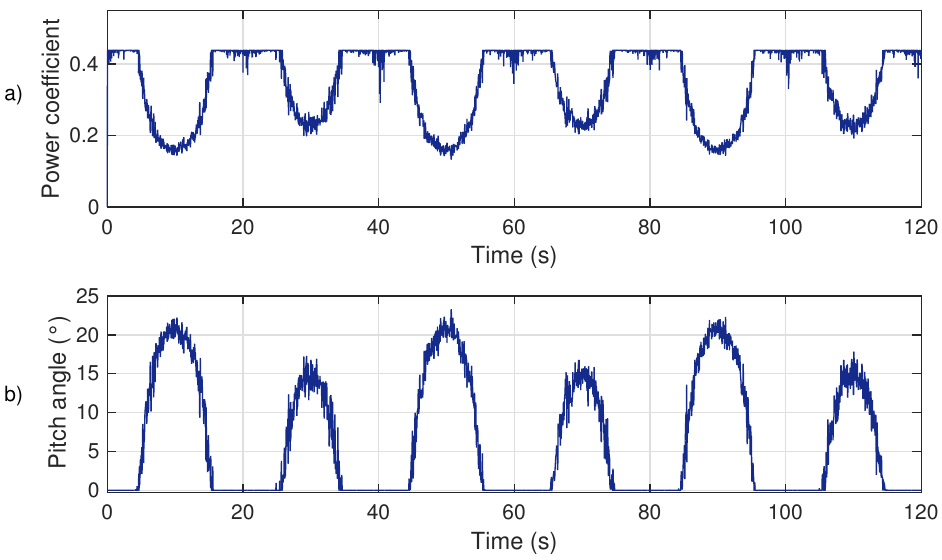
Figure 17. Control performances of case 1: ( a ) power coefficient variation; ( b ) pitch angle